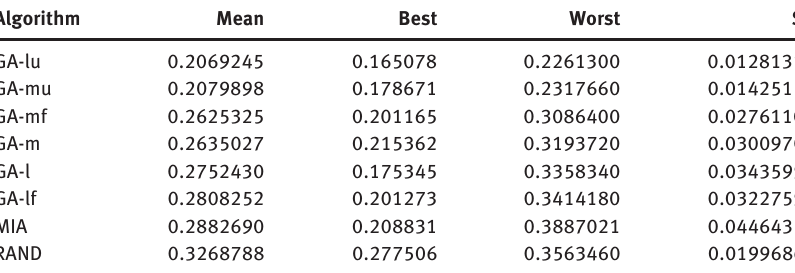
Table 5. Length 58 2 PSK